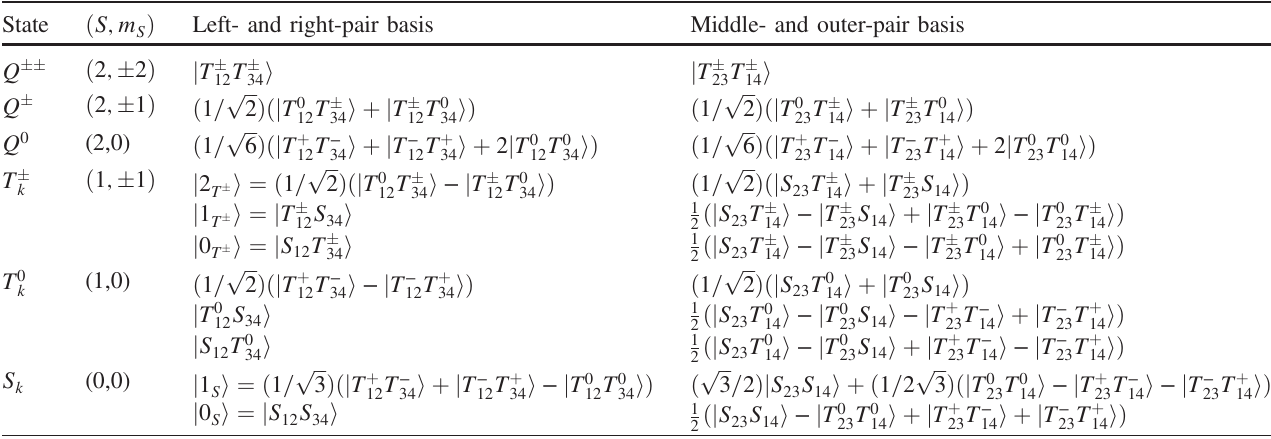
ˆ ˆ S 2 and S z expressed in a basis of two-spin singlets and triplets on either the left and right or TABLE I. Four-spin shared eigenstates of middle and outer pair. States in the rightmost column are the same as states on the same row in the column to the left of it. The four-spin states shown here are, in general, not eigenstates of the Heisenberg Hamiltonian, but the Hamiltonian does operate within a specific ð S; m Þ subspace. S